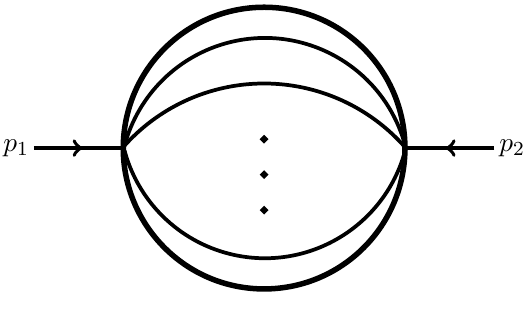
Figure 3 . ‘ -loop sunset